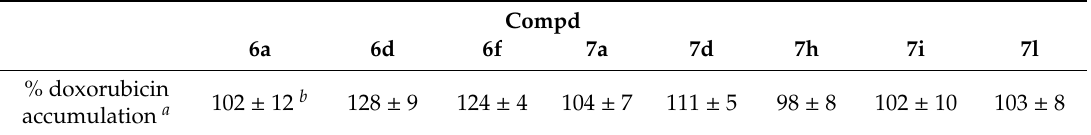
Table 4. Percent doxorubicin accumulation in multidrug resistant A2780/DX3 cells after co-treatment with compounds 6 and 7 .